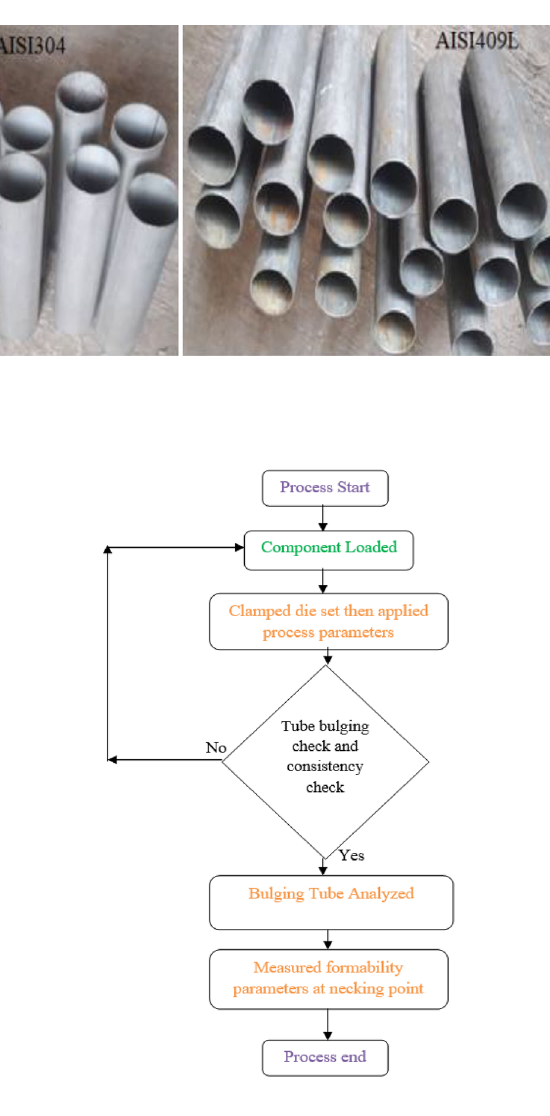
Fig. 6 Experimentation procedure